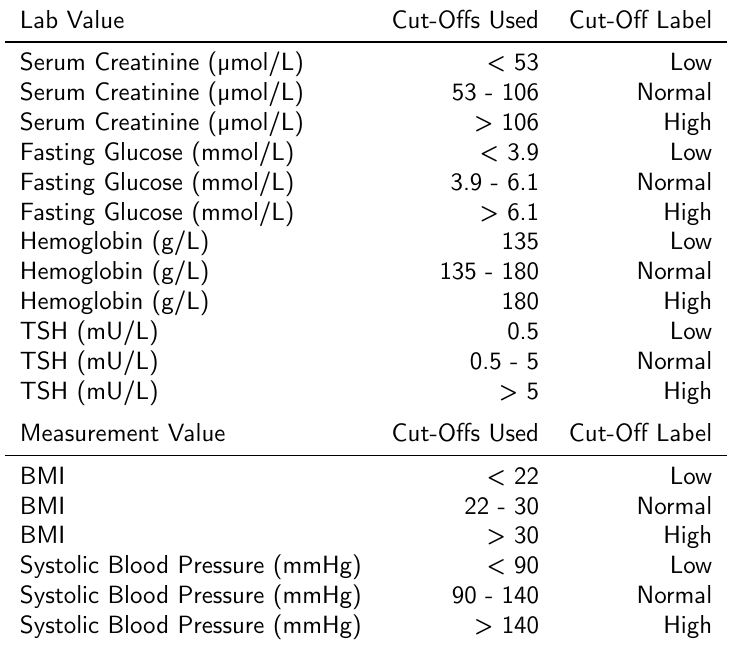
Table 2: Cut-offs for Lab and Measurement